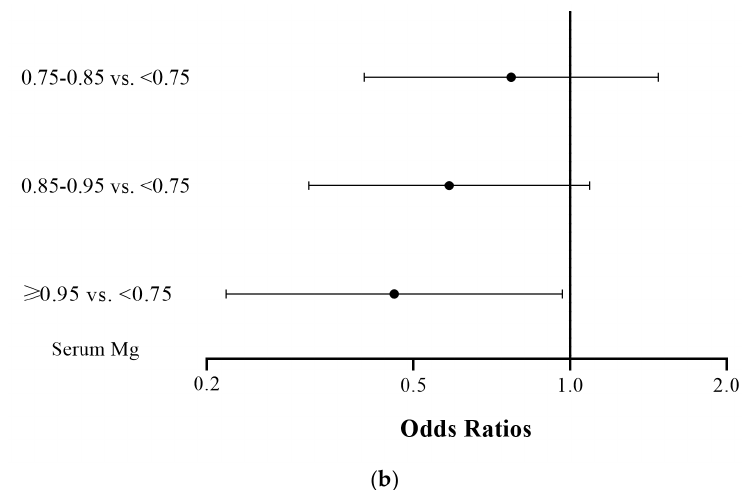
Figure 2. ( a ) Adjusted β (regression coefficient) of depressive symptoms versus serum magnesium (Mg). The reference group was serum Mg < 0.75 mmol/L. From top to bottom, β value for the three comparisons were [ − 0.077 (95% CI − 0.210–0.056)], [ − 0.128 (95% CI − 0.254– − 0.002)], and [ − 0.180 (95% CI − 0.319– − 0.041)]. ( b ) Adjusted odds ratios of depressive symptoms versus serum magnesium (Mg). The reference group was serum Mg < 0.75 mmol/L. From top to bottom, the odds ratio for the three comparisons were [0.770 (95% CI 0.402–1.477)], [0.585 (95% CI 0.314–1.090)], and [0.459 (95% CI 0.218–0.966)].